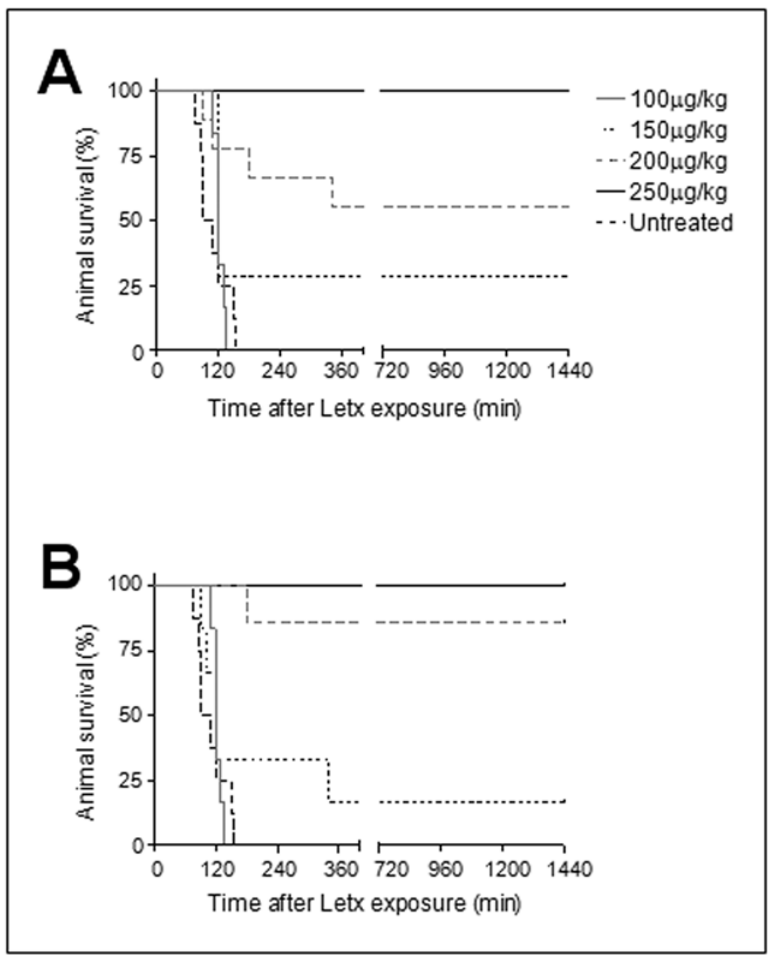
Figure 3. Invivo LeTx neutralization. Rats (n $ 6 for each group) were i.m. administered with the indicated doses of (A) cAb 29 or (B) mAb 29, followed by i.v. challenge with LeTx (20 m g PA and 10 m g LF), 17 hours later. Animal survival was monitored for the next 24 hours.